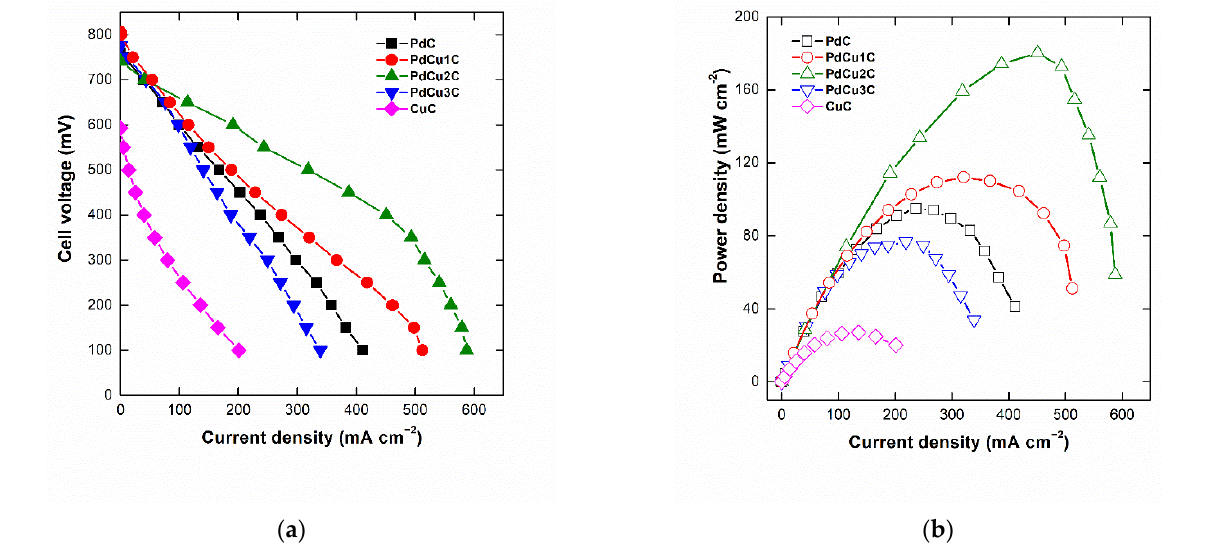
Figure 5. ( a ) Cell voltage and; ( b ) power density curves for the different electrocatalysts in a DHFC at 60 °C (anode: 1 mol L − 1 hydrazine and 4 mol L − 1 KOH, cathode: 30 mL min − 1 O 2 ; electrolyte: KOH-doped polybenzimidazole).